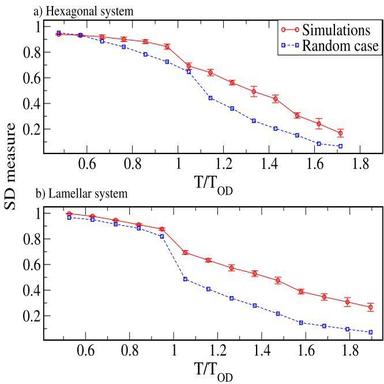
Sørensen-Dice similarity coefficient as a function of relative temperature for the hexagonal system (a) and the lamellar system (b). The red curve with circles represents the SD values obtained from the simulations, while the blue curve with squares shows the expected values for a random case.